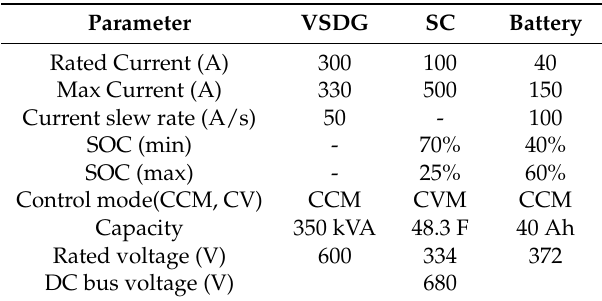
Table 2. Hybrid System Specifications.